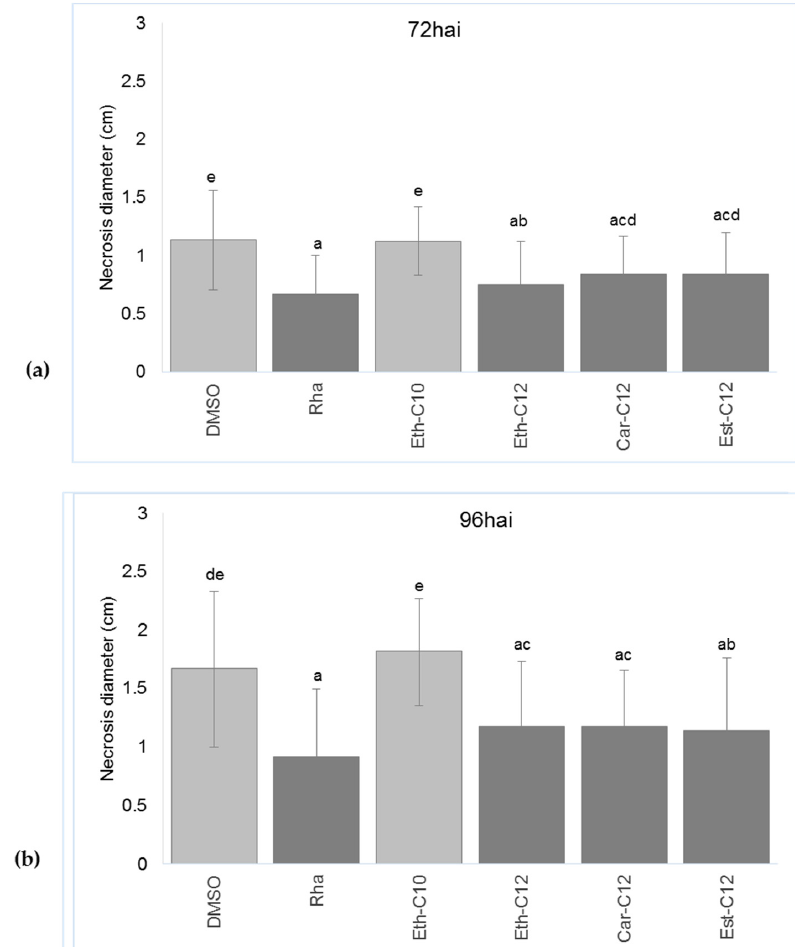
Figure 6. Impacts of smRLs on necrosis symptoms caused by B. cinerea on tomato leaves. Plants were sprayed with 300 µM of smRLs, natural rhamnolipid mix (Rha) or DMSO 0.1% and 3 days later, detached leaves were inoculated with the fungus. Necrosis diameter measures ( a ) 72 hai; ( b ) 96 hai. Values shown are means +/ − SD of three independent repetitions (each repetition was realized in triplicate and each replicate consisted of four leaves). Different lower-case letters indicate significant differences between the treatments, as determined by an ANOVA followed by the Tukey-HSD post-hoc test ( p ≤ 0.05).